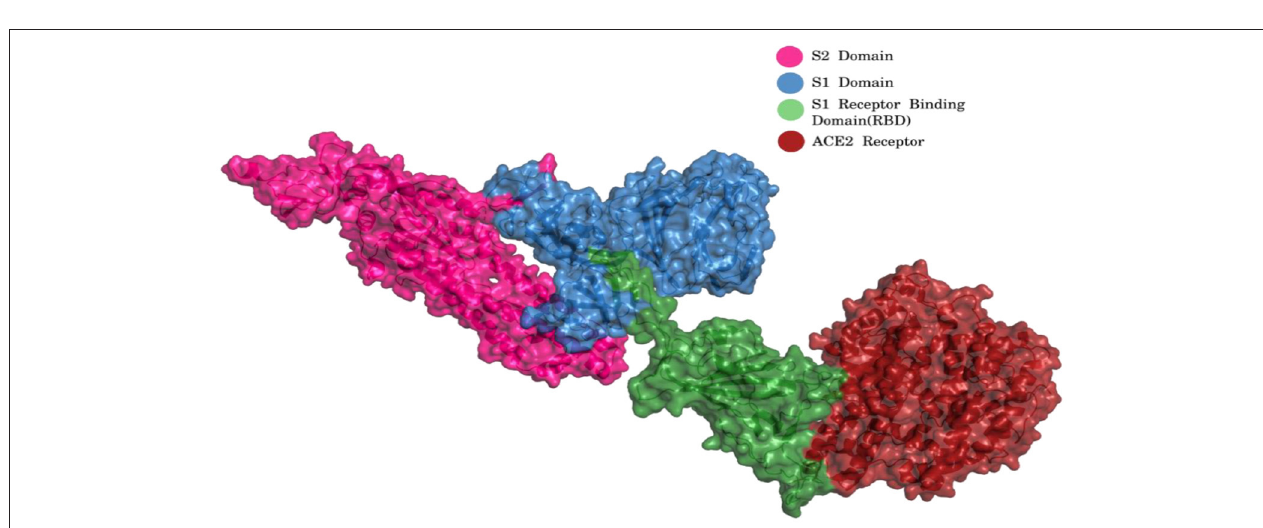
FIGURE 2 | S1 and S2 region of spike glycoprotein and ACE2 receptor [Blue, S1 Domain; Pink, S2 Domain; Green, S1 Receptor binding domain (RBD); Red, ACE2 Receptor] (PDB ID 7KJ2).